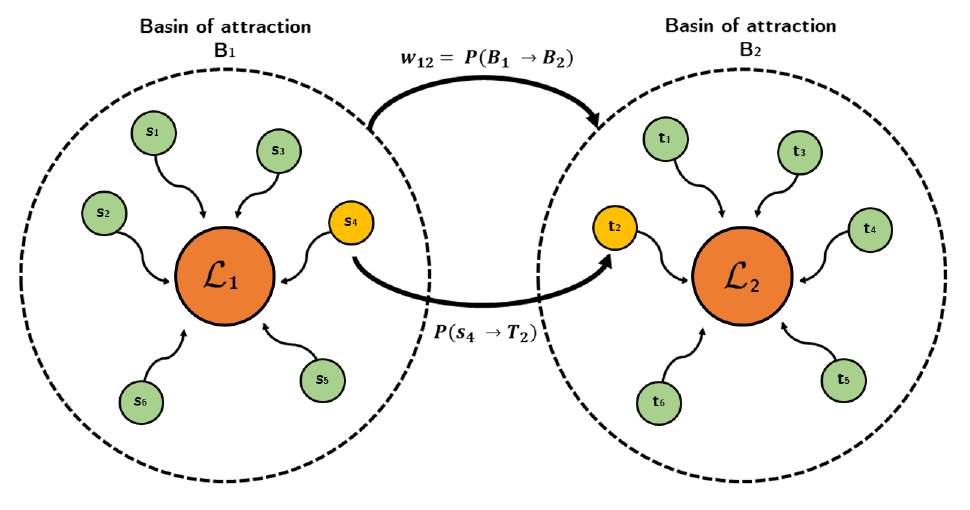
Figure 3. Basins-transitions between local